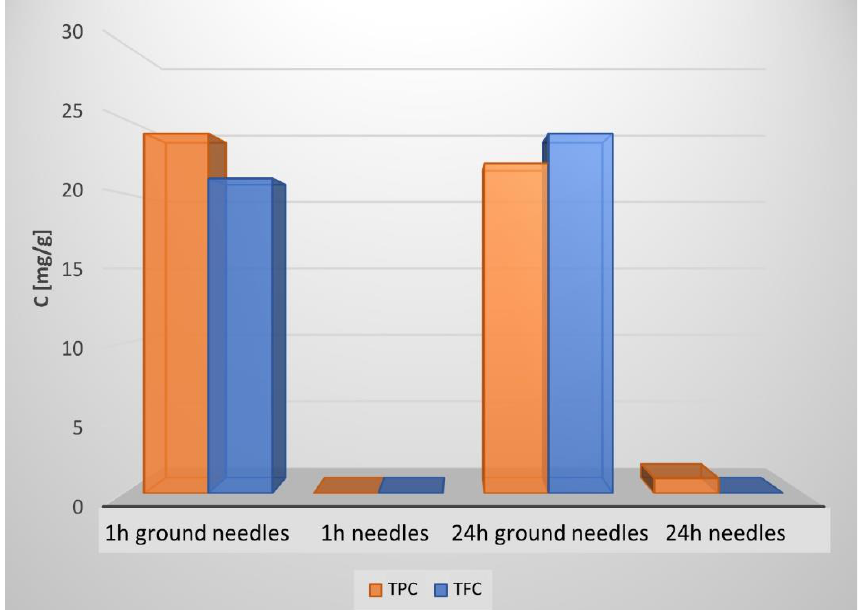
Figure 3. Comparisons of total phenolic content (TPC) and total flavonoid content (TFC) extracted from ground needles and non-ground needles (1 and 24 h extraction times).